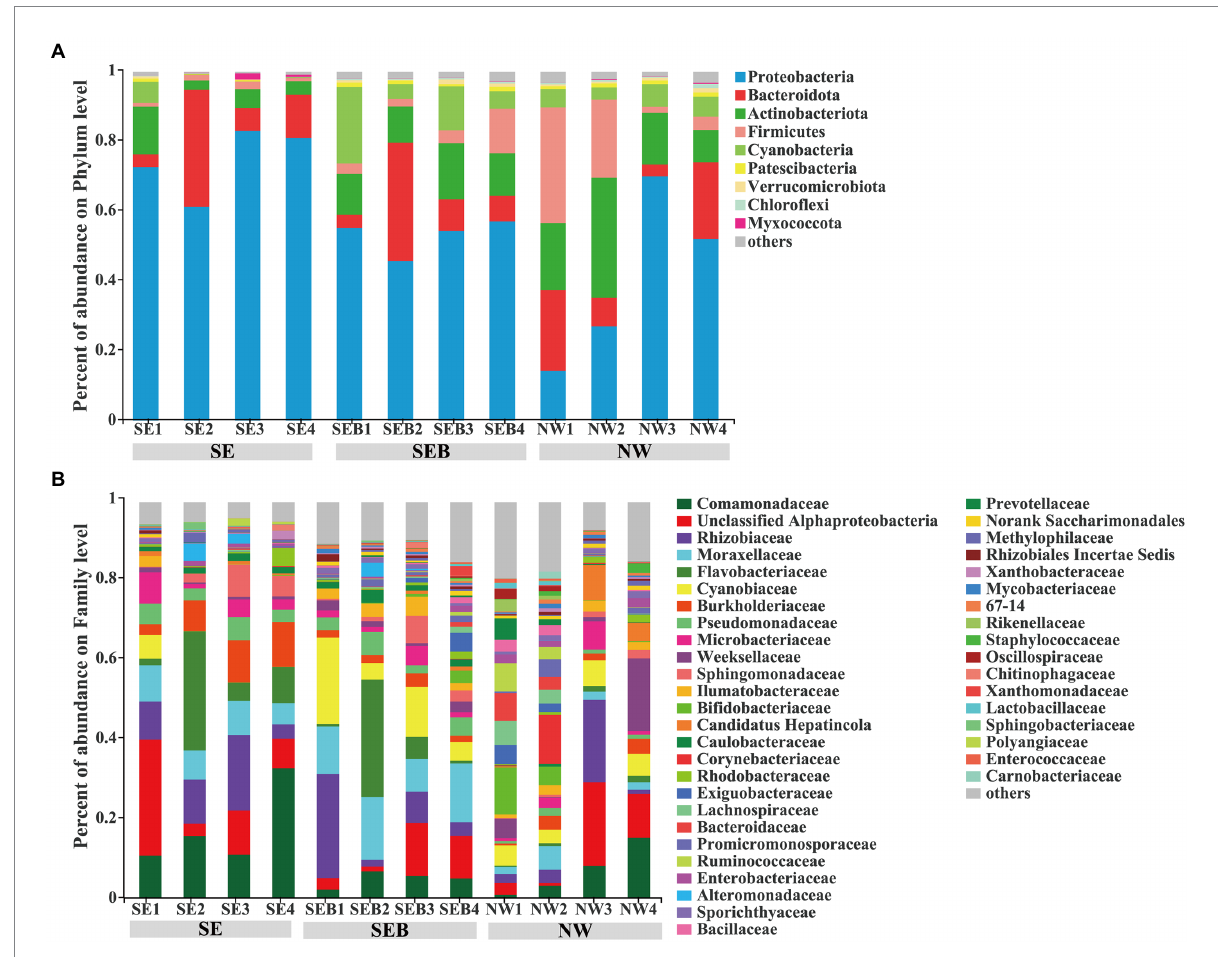
FIGURE 4 Composition of B. calyciflorus -associated bacterial communities. (A) at phylum level, (B) at family level. The abscissa is the name of the sample, the ordinate is the proportion of the species in the sample, the columns of different colors represent different species, and the length of the columns represents the proportion of the